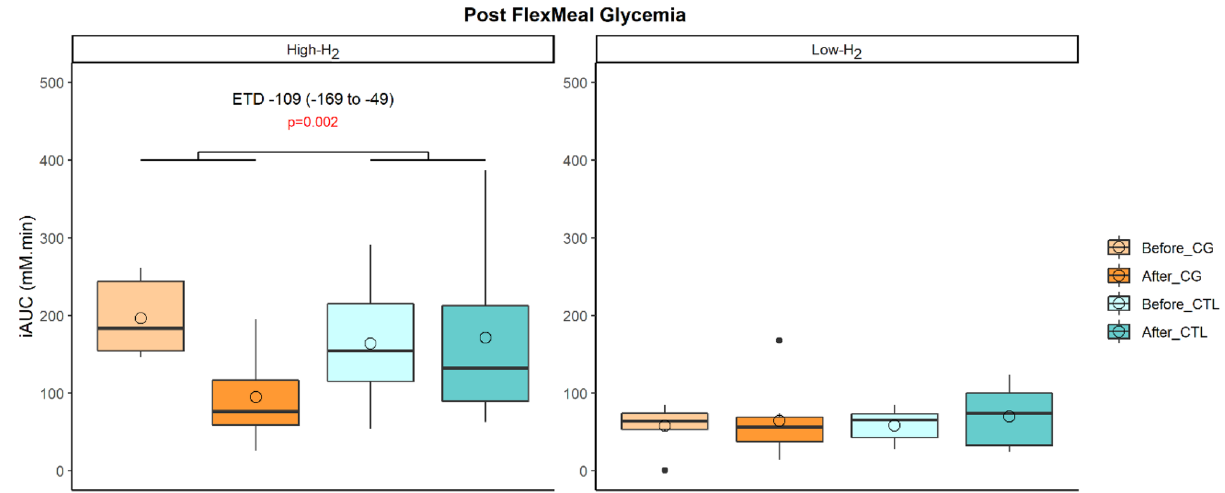
Figure 5. Impacted metabolic parameters according to gut fermentation profile (High-H 2 (n = 8); Low-H 2 (n = 7)). Empty circles and horizontal lines within each box represent respectively the mean and median values. A mixed linear model with treatment, time, period, sequence and subgroup as fixed variables and subjects as random effect has been performed once the interaction time*treatment*subgroup has been tested and showed significance. p values associated to CG effect assessed with the estimated treatment difference (ETD) and its 95% confidence interval is shown and considered as significant when <